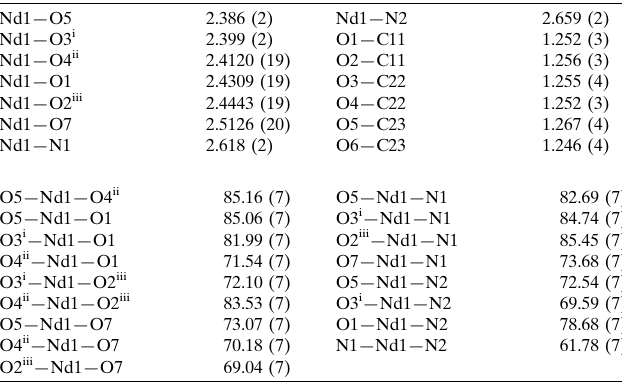
Selected geometric parameters (A˚ , (cid:1) ).